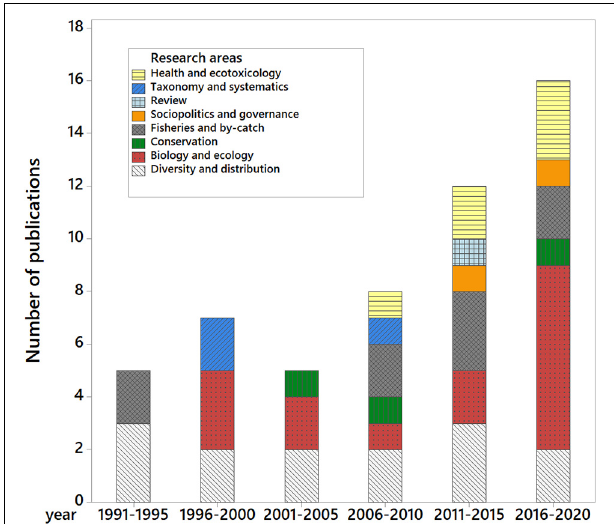
FIGURE 3 | Summary of peer-reviewed journal articles and conference proceedings on Philippine marine mammals from 1991 to present in 5-year periods. Annual publication rate range between 0 and 5 papers a year ( ¯ X = 1.77 ±